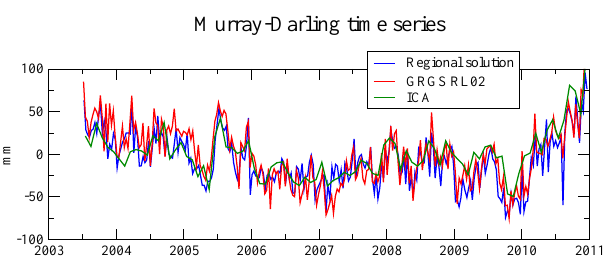
Fig. 14. 10-day and monthly time series of averaged total water storage over the whole Murray–Darling Basin from 2003 to 2011 computed from 10-day regional solutions (blue line), 10-day GRGS global solutions (red line) and monthly ICA 400km-filtered solu- tions (green line).